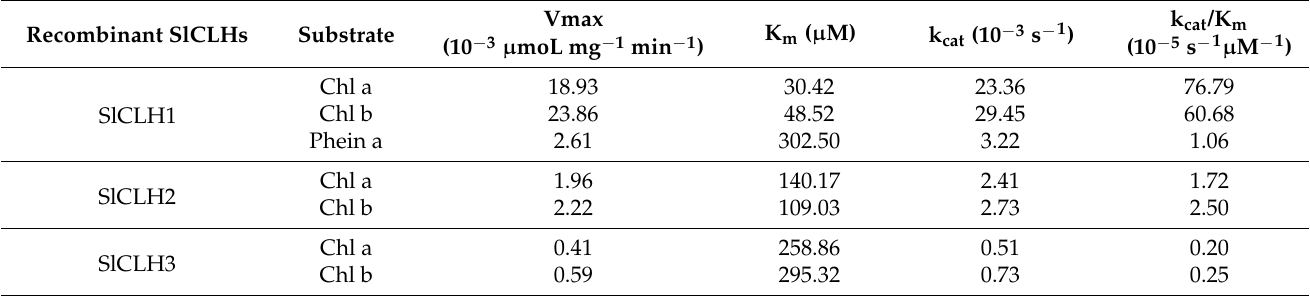
Table 2. Substrate specificity and kinetic parameters of recombinant